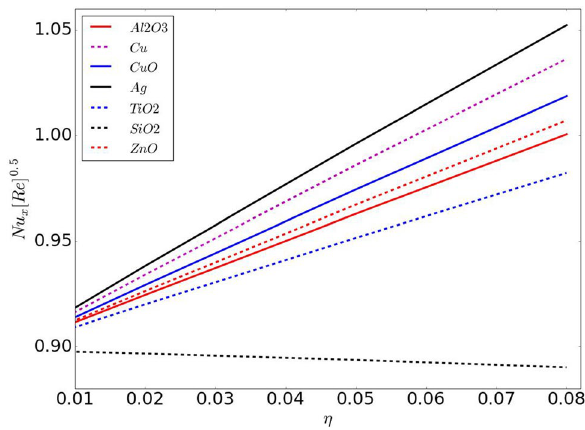
Fig. 18 Velocity profile for various nanofluids with 𝜉 = 0.5 and 𝜙 = 0.05